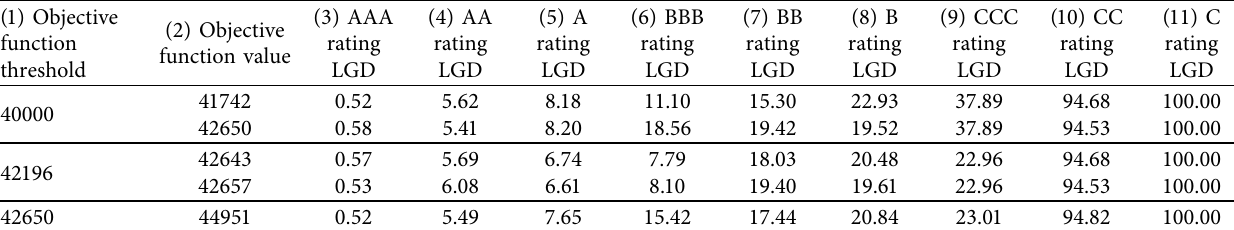
Table 4: Default loss rate of different credit ratings.